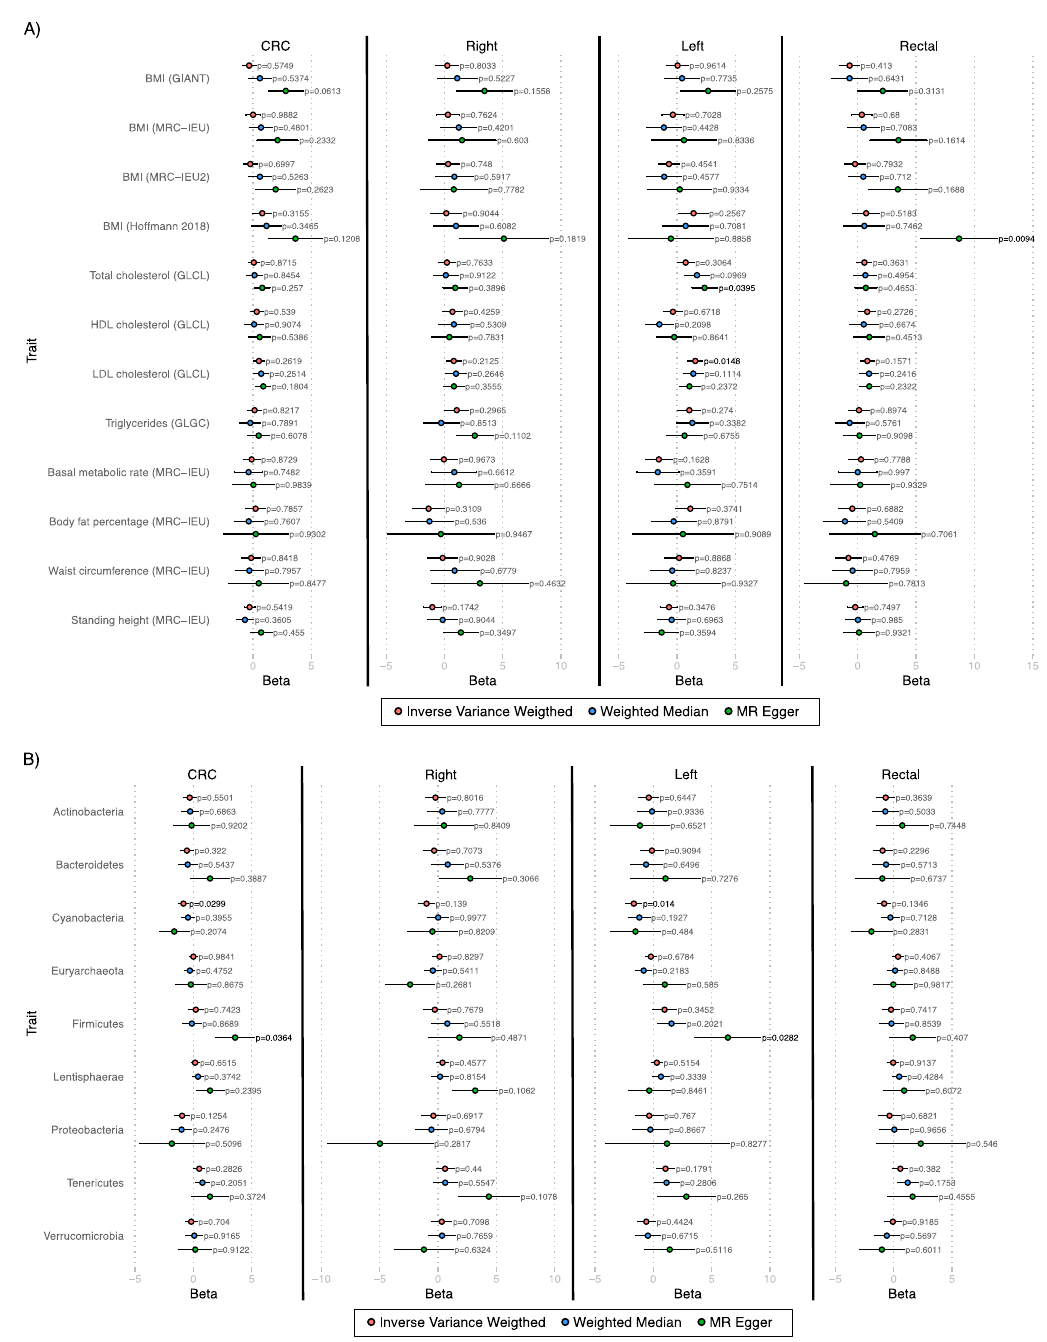
Figure 1. Mendelian Randomization results. The beta value and standard error are depicted for each method used. ( A ) Modifiable risk factors. ( B ) Bacterial